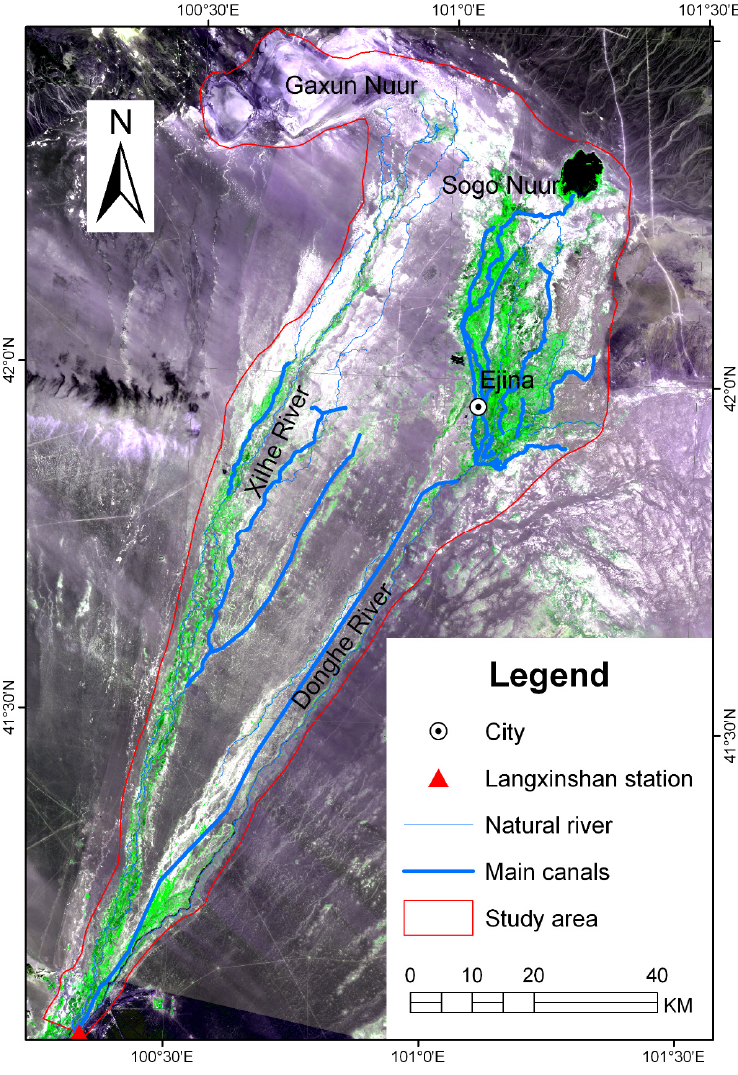
Figure 1. The study